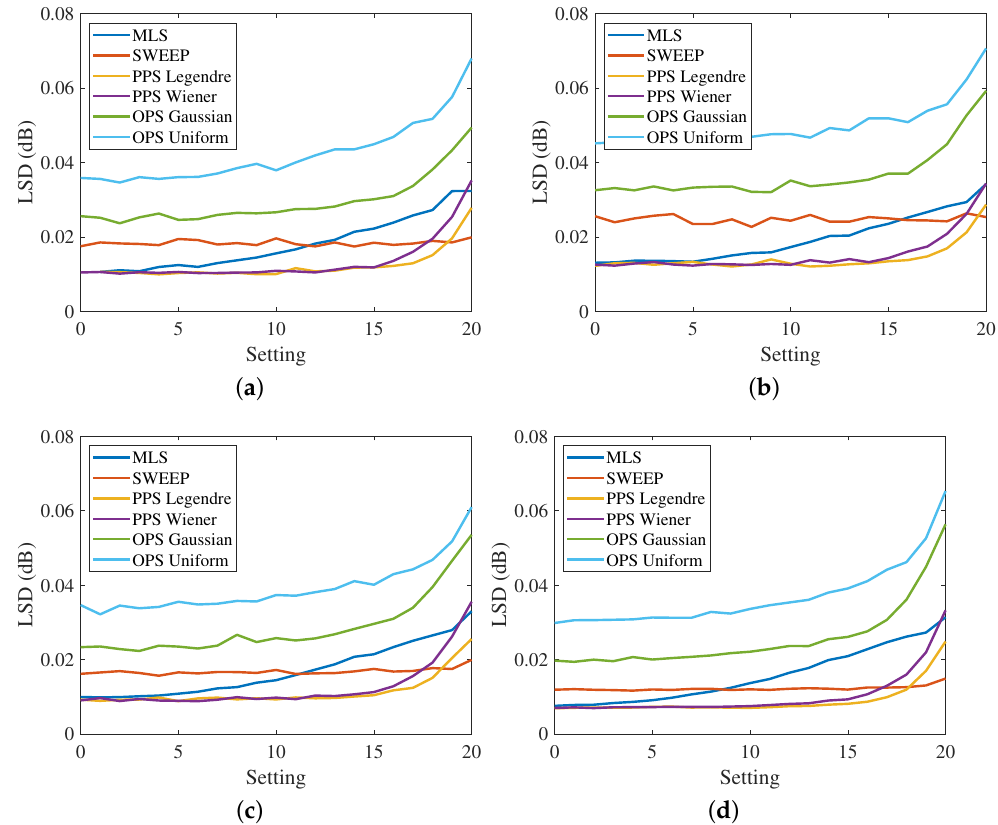
Figure 9. Log-spectral distance in the band [100, 18000] Hz at the different settings with the MIC-100 preamplifier for ( a ) the response of the left ear from the left speakers, ( b ) the response of the left ear from the right speakers, ( c ) the response of the right ear from the left speakers, and ( d ) the response of the right ear from the right speakers with a 40 dB output